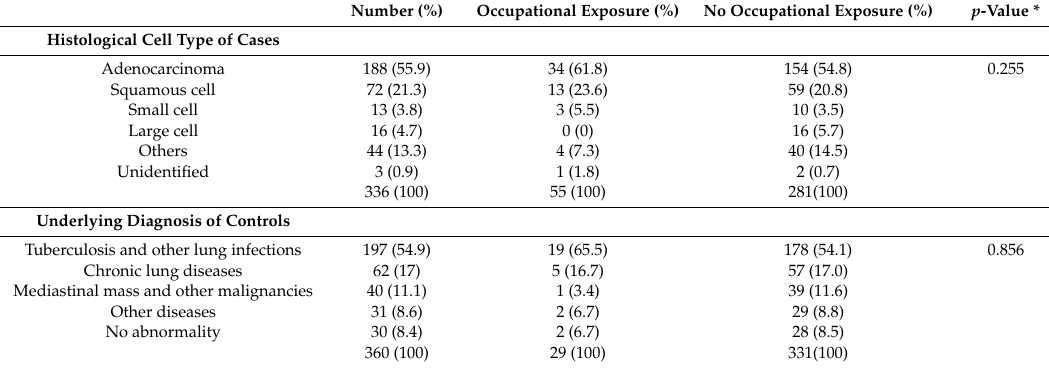
Table 4. Histological cell type of case group and the underlying diagnosis of the control group according to occupational asbestos exposure.